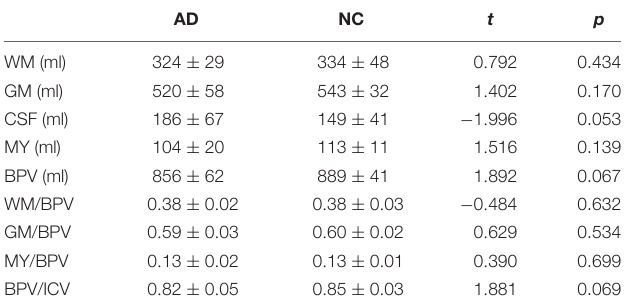
TABLE 1 | The parameters obtained from brain segmentation of MAGiC in AD patients and normal controls after regressing out the effects of age, gender, and intracranial volume.